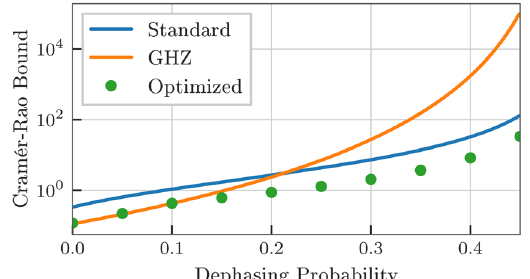
Fig. 2 Realizing the algorithm. Realization of the approach proposed in Fig. 1 for the encoding of Eq. (7). a On a sensing platform or during its emulation, the output probabilities are directly computed from the POVM measurements. The derivatives are computed using the parameter-shift rule. b When simulating on a quantum computer, the action of the noise channel is simulated by altering the POVM. The derivatives are computed by measuring the expectation values of a set of operators, used in training the network.